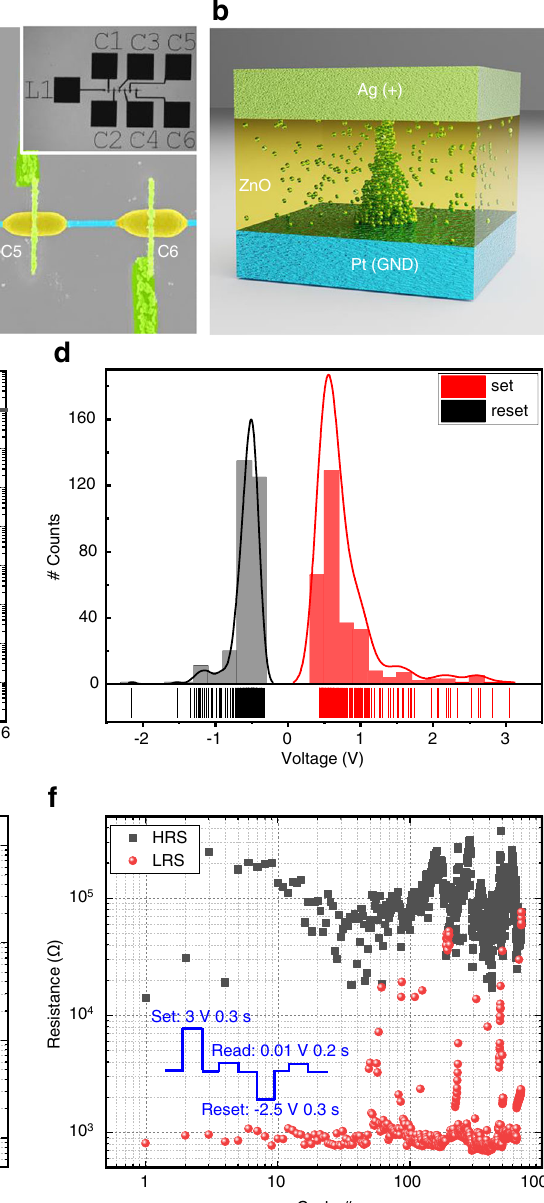
cycle number 300 (green) are emphasized by color, all other cycles are shown in gray. d Histogramsofthesetandresetvoltagesmeasuredinthe300cyclesinpanel c . e Thestableretentionperformanceofbothresistivestatesonatimescaleofupto 10 4 s. f , Resistive switching endurance of a single memristor under short-pulse- voltage mode (see inset) over 700